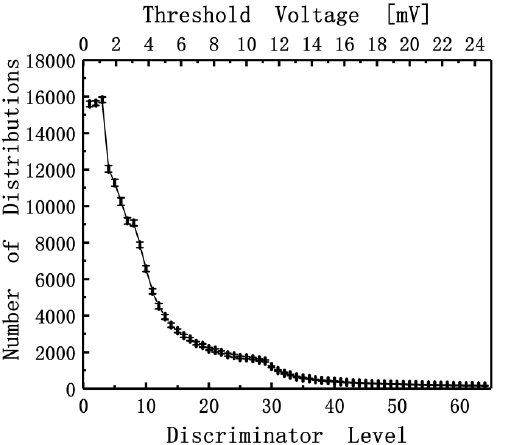
Figure 8. The number statistics of non-zero data points in a probing profile with di ff erent preset discriminator levels of the Licel transient recorder TR40-160 in the ultraviolet elastic scanning